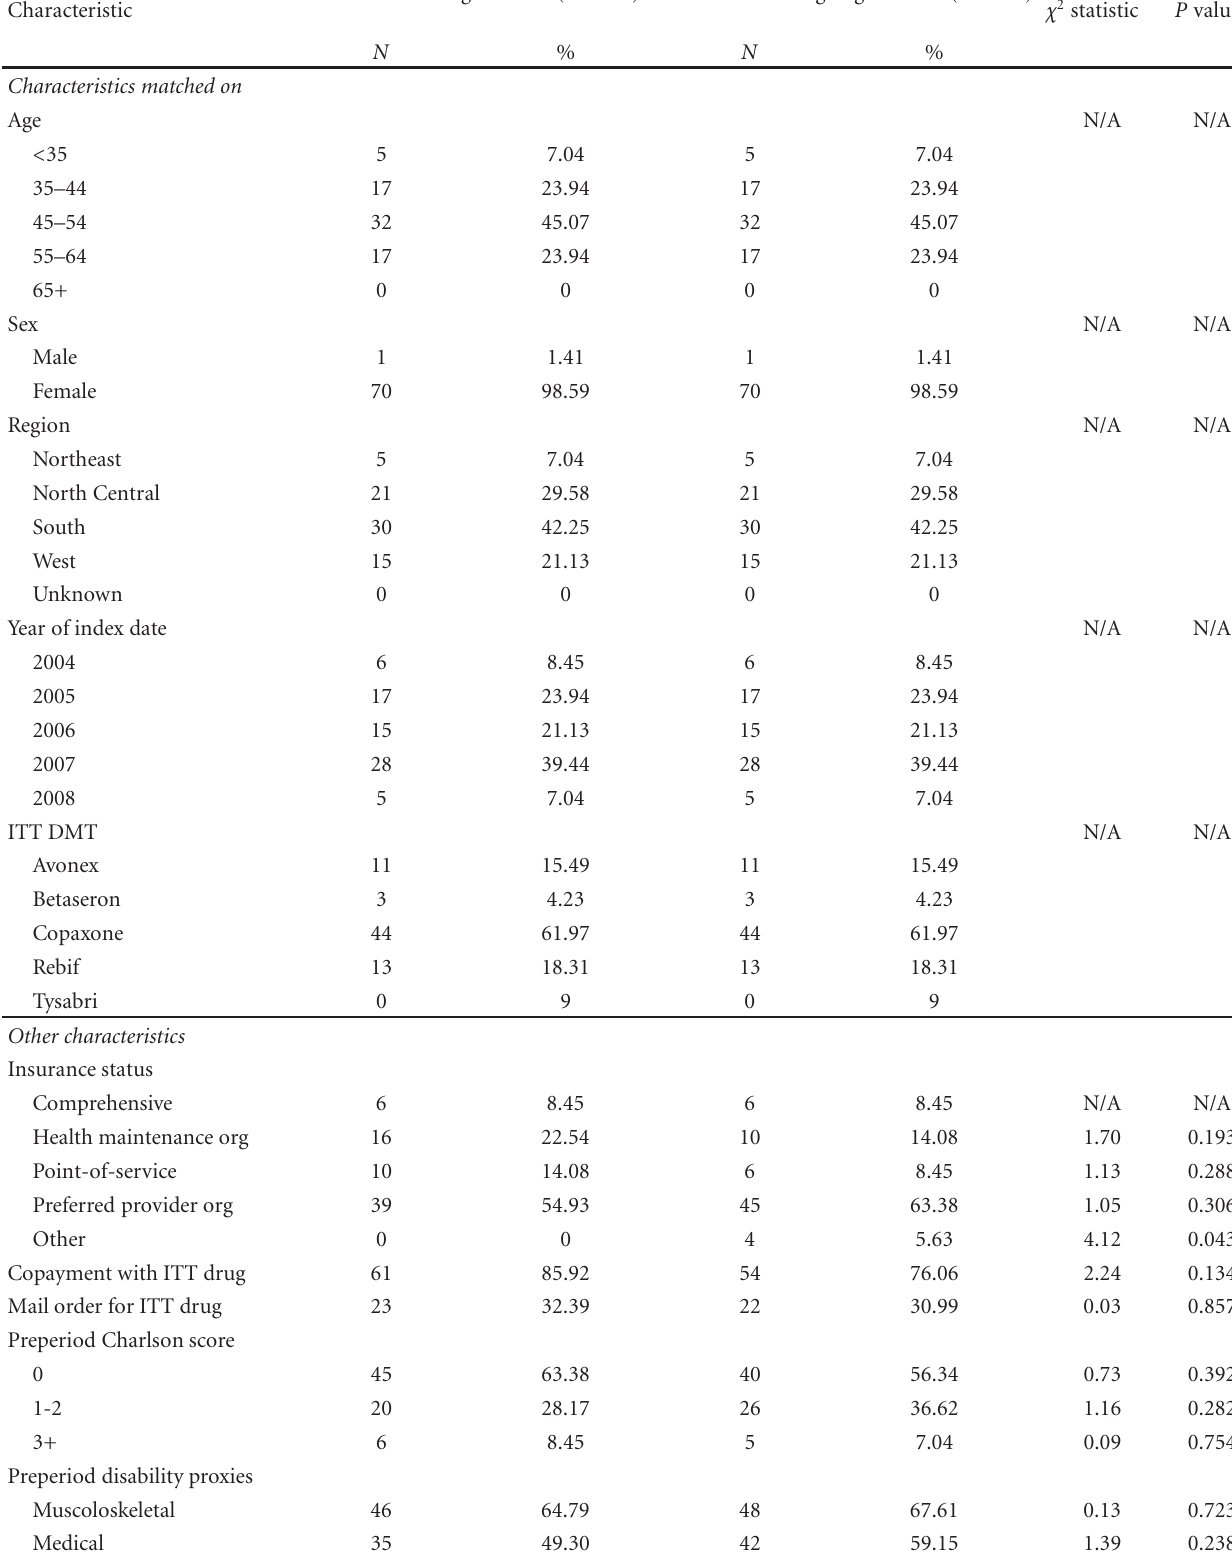
Table 3: Patient characteristics: MS patients treated with antidepressants for at least 6 months compared to MS patients treated with antidepressants for less than 6